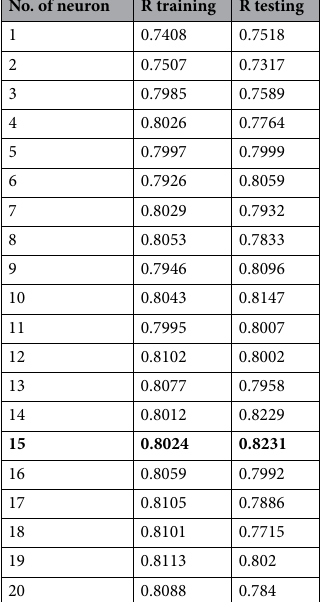
Table 1. Selection of Optimum Number of Neurons based on R. Significant values are in